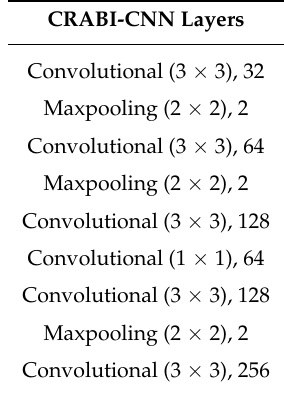
Table 1. Proposed CRABI-CNN